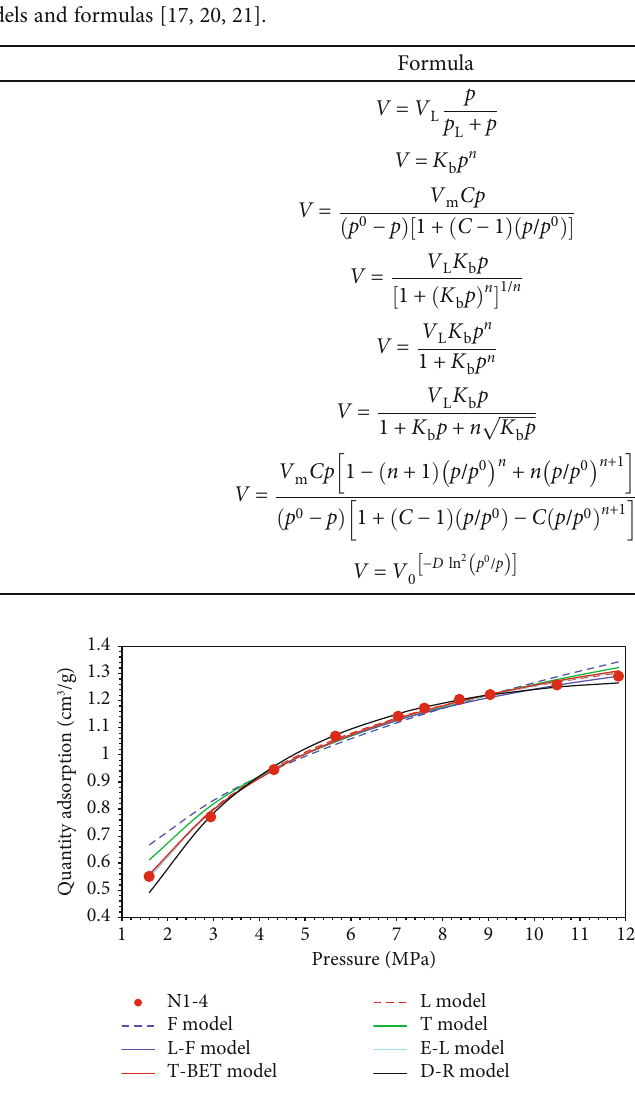
Figure 6: Fitting curves of di ff erent adsorption models for Changning shale